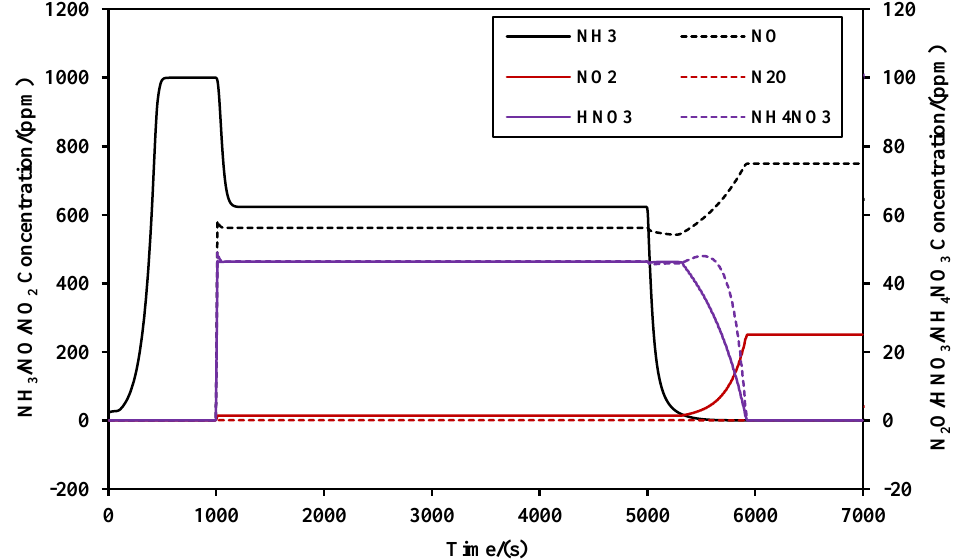
Figure 5. The relationship between the concentration of each component at the outlet of the SCR system and the change of time ( T = 150 °C, NO 2 /NO x = 0.25).